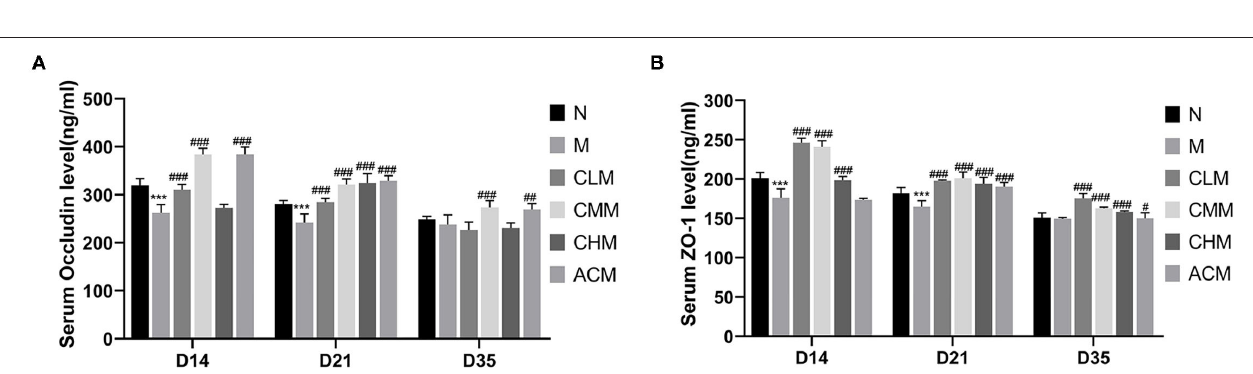
FIGURE 4 | Effects of CSP on the levels of IL-4 (A) , IL-10 (B) , IgM (C) , IgG (D) and TNF- β (E) in serum of chicken. Data are expressed as mean ± SD.* p < 0.05, ** p < 0.01, and *** p < 0.001 compared with N group; # p < 0.05, ## p < 0.01, and ### p < 0.001 compared with M group.